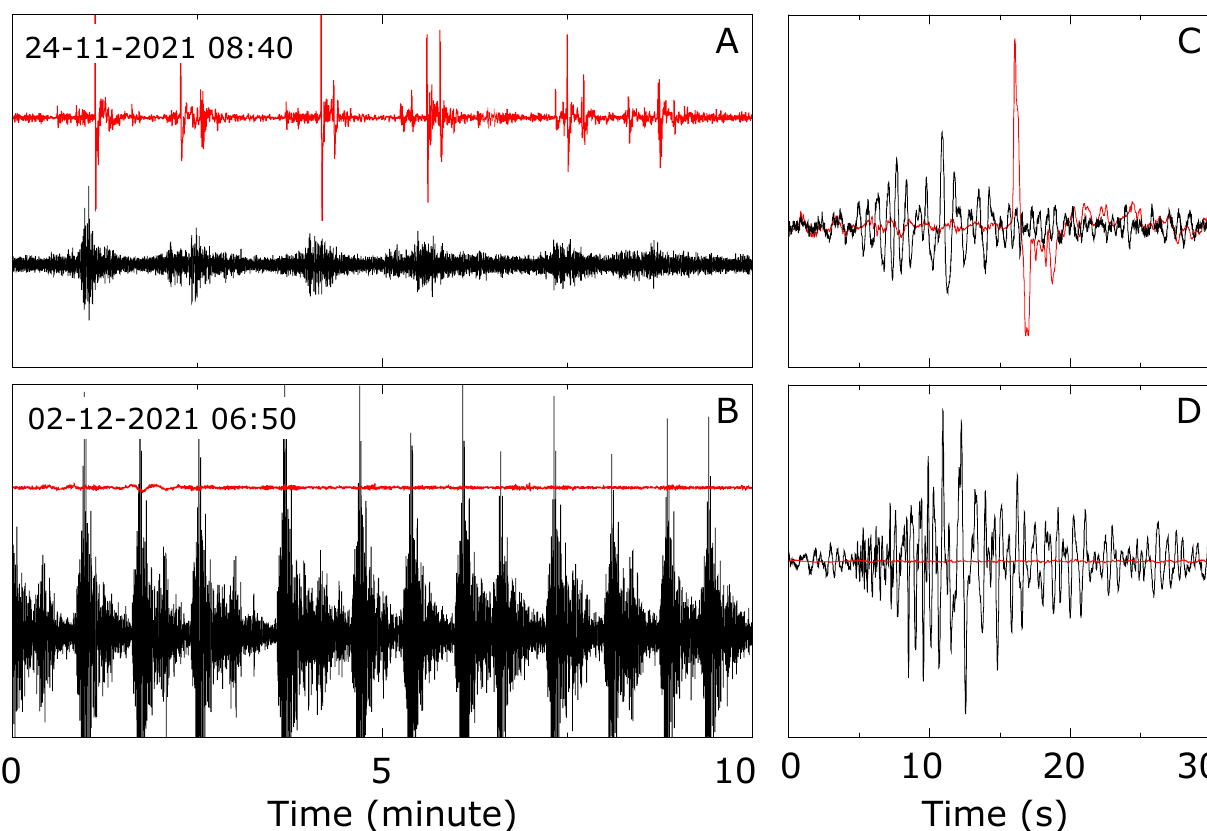
Figure 10: Waveforms registered at SAGA station. [A] and [B] 10-minute sequences for vertical seismic (black) and acoustic (red) components recorded respectively during standard low-amplitude explosive activity observed since July 2021 and during the drumbeat sequence. [C] and [D] Example of events recorded respectively during the two sequences: an explosion quake with clear acoustic phase and a drumbeat